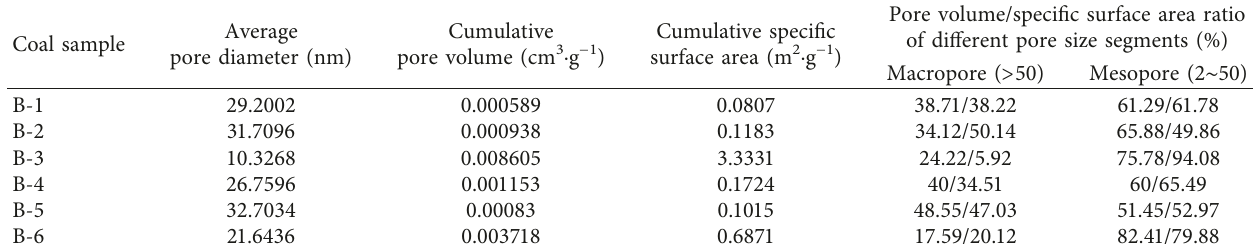
Table 3: Specific surface area, pore volume, and pore size of raw coal